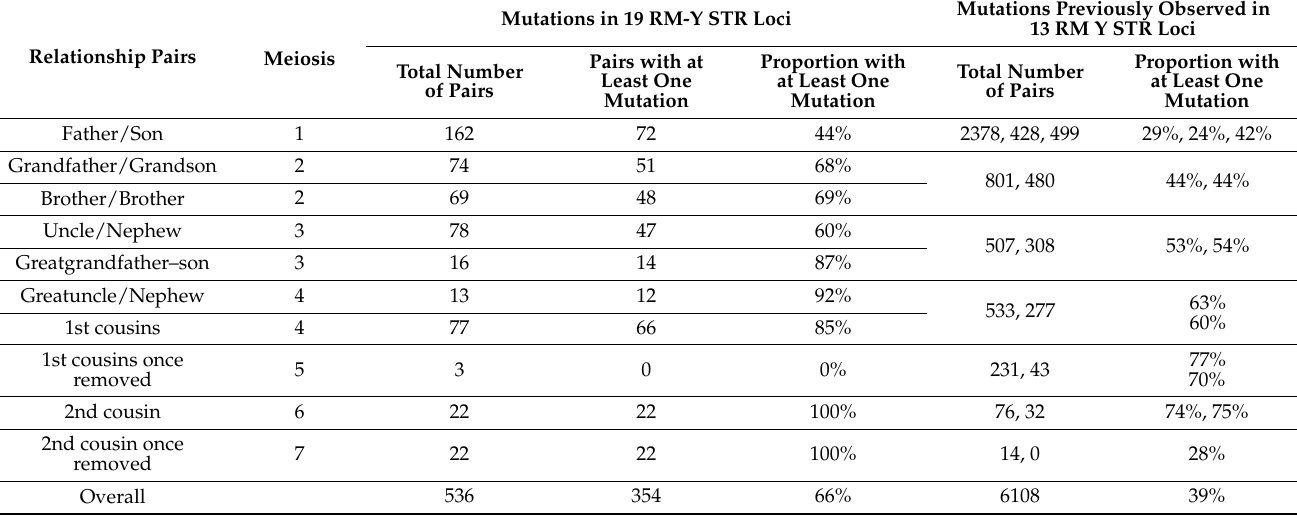
Table 2. Comparison of the mutations observed at 19 RM Y STR and previously observed in 13 RM-YSTR loci